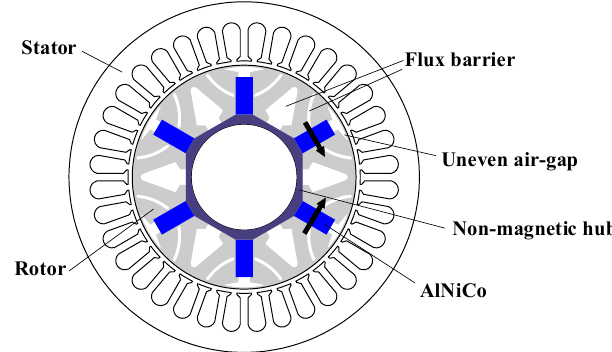
Figure 24. Spoke ‐ type VFM machine [71].